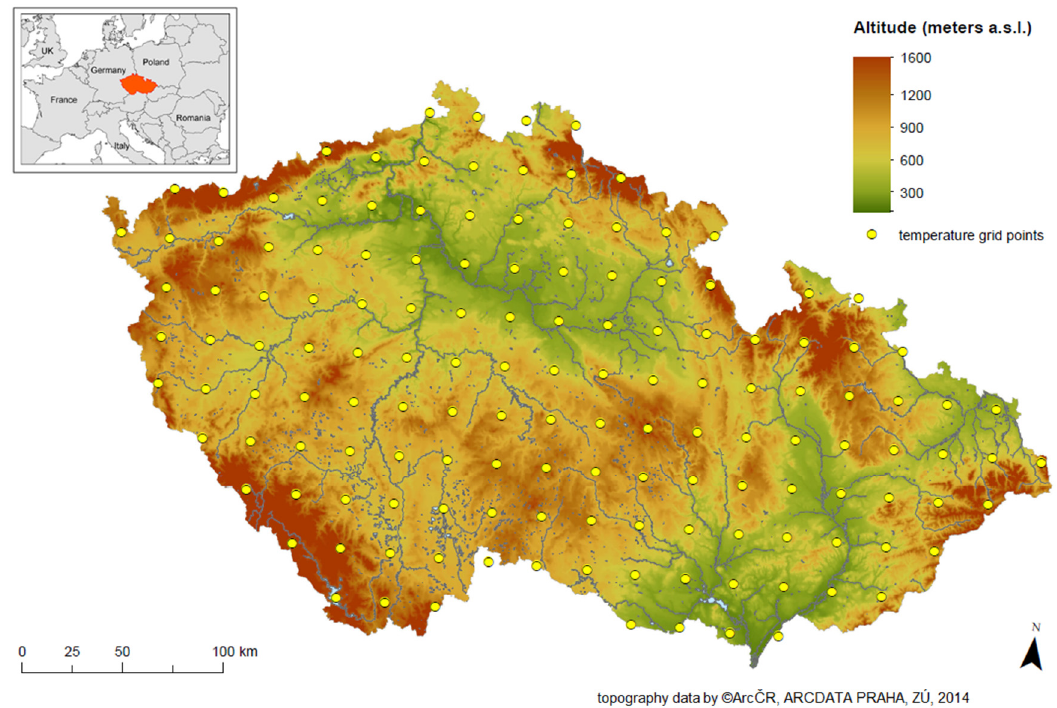
Figure 1. Topography of the Czech Republic (Digital Elevation Model provided by ARCDATA PRAHA) and distribution of regular temperature grid points (GriSt data set as described in [49]).